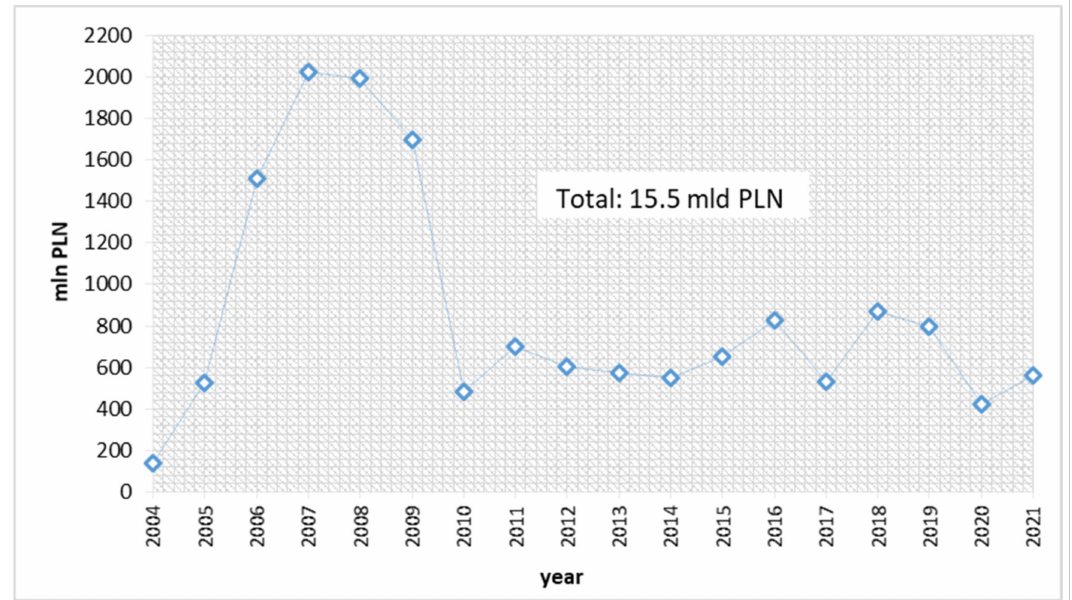
Figure 5. Expenditure on investment in the Polish steel industry from 2004 to 2021. Source: Polish Steel Association, Katowice, Poland